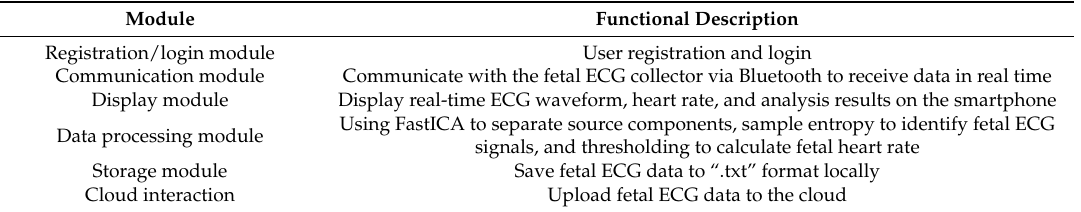
Table 1. App software modules.